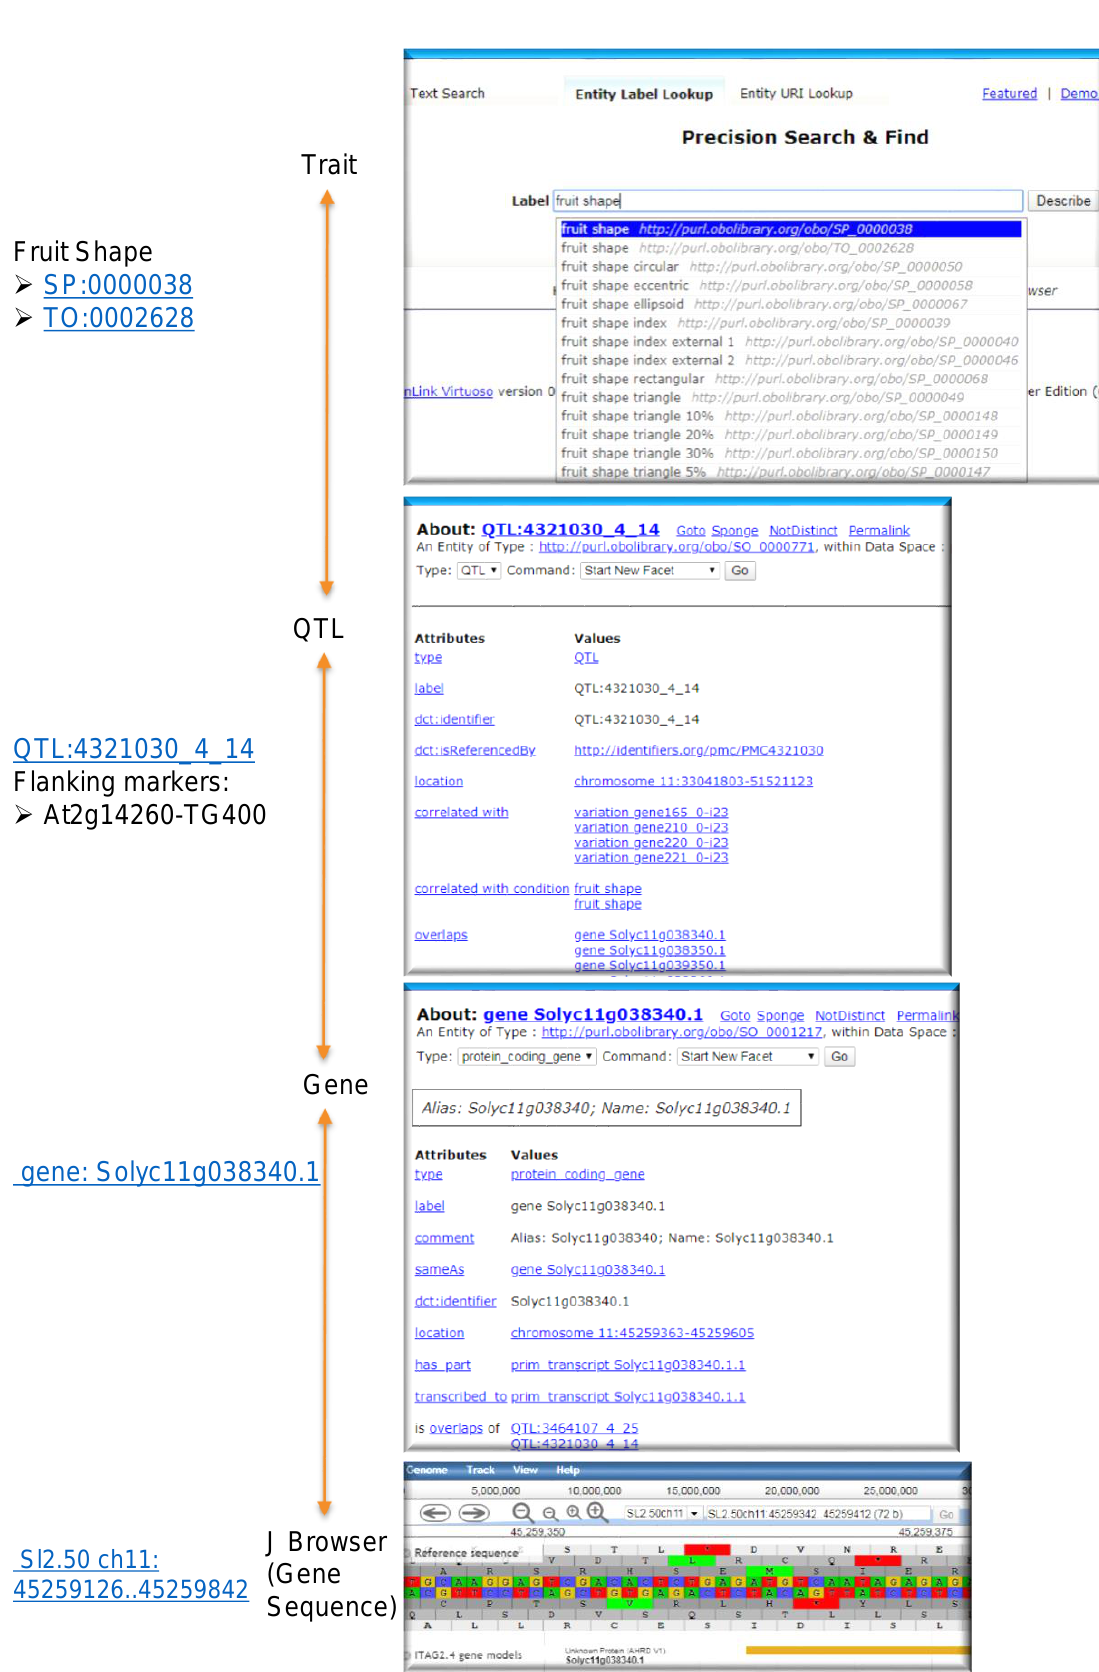
Figure 2. Browsing trait-gene associations in the Faceted Browser for the example trait “fruit